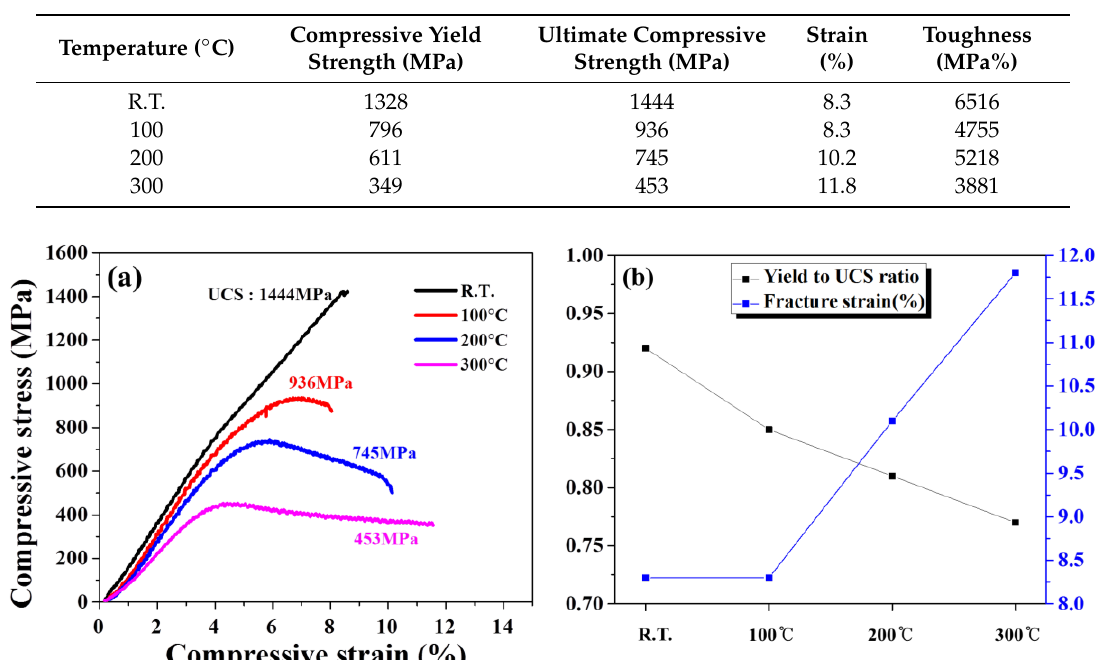
Table 1. Mechanical properties of AMCs at variable temperature.